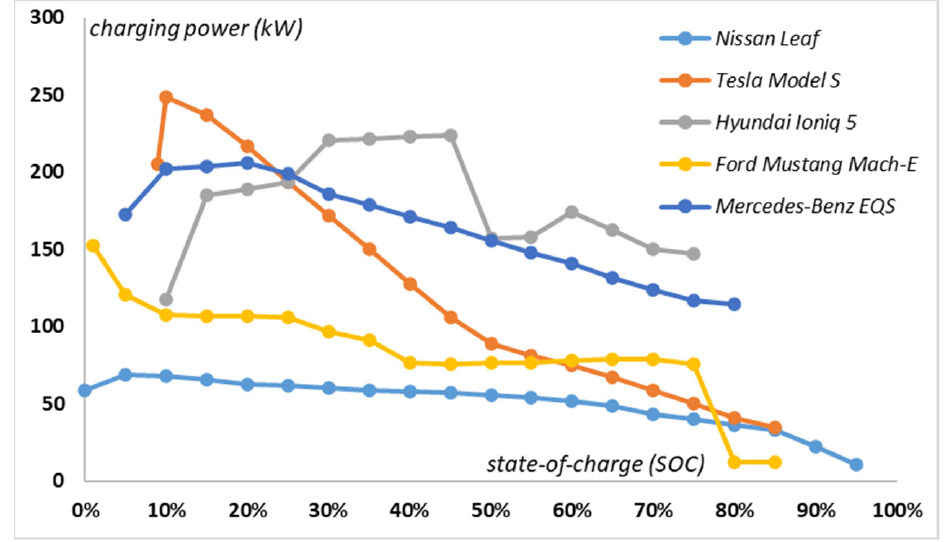
Figure 10. Instantaneous charging power and SOC.